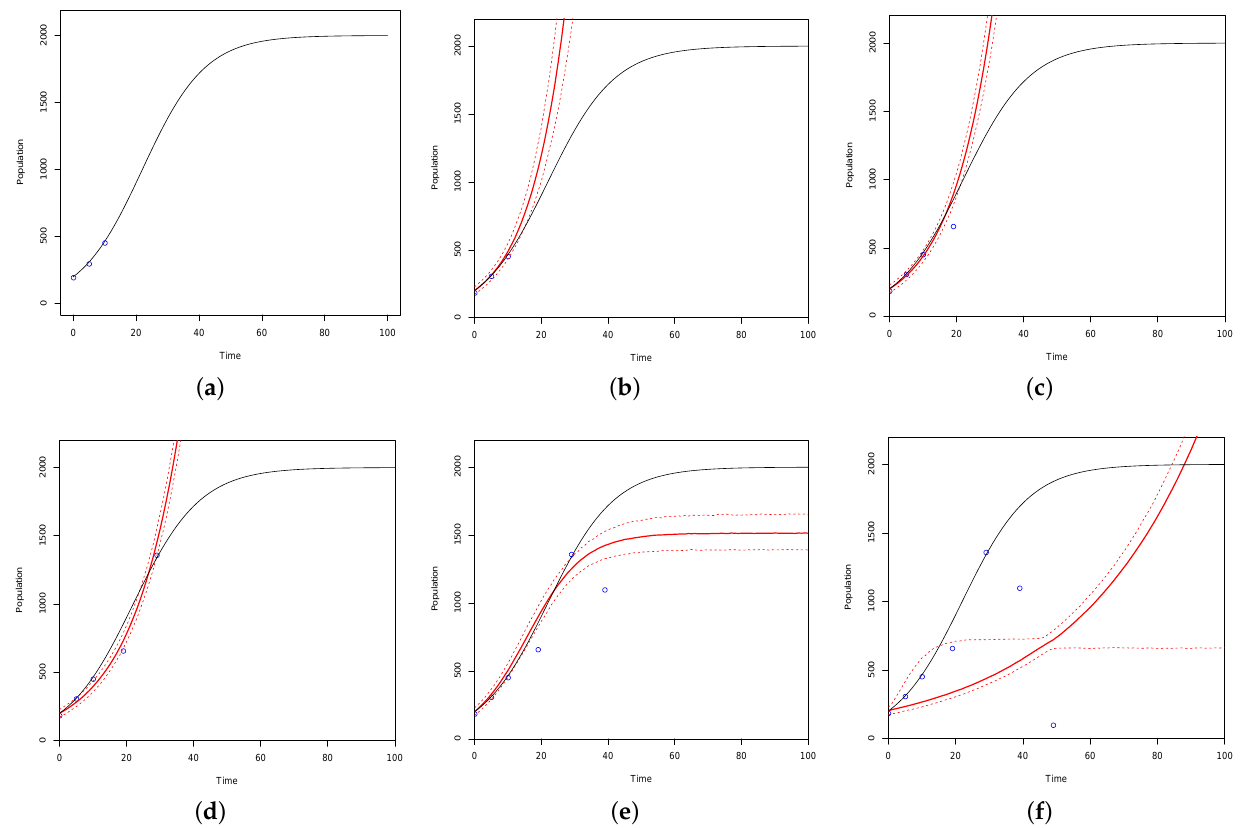
Figure 13. 10,000 MCMC samples are used to simulate normal 10% logistic growth across a 100 day period with a carrying capacity of 2000. The ground truth model is plotted as a black curve. I-optimality criterion guides the sequential optimality process. The optimal design points are plotted in blue and are fit by a solid red curve. The red dotted lines represent the 2.5% and 97.5% quantiles of the predicted values. Panel ( a ) plots the base design of three points, panel ( b ) plots the fit of the base design, and panels ( c – f ) plot the fourth through seventh optimal points in the design as they are fit. This simulation demonstrates a lack of fit